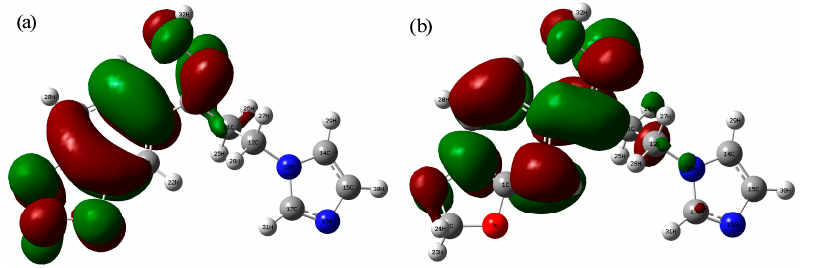
Figure 6. ( a ) HOMO ( b ) LUMO orbital of compound 4 .